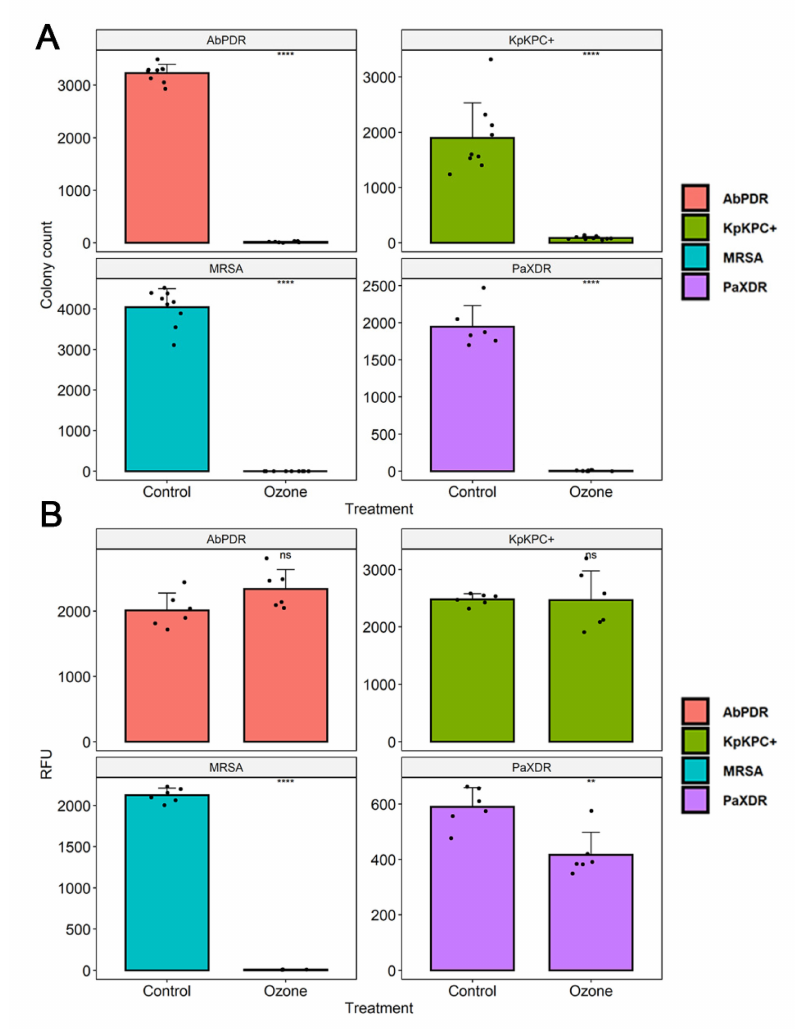
Figure 4. ( A ) The number of colony-forming units (CFU) in different bacterial strains ( S. aureus (MRSA), P. aeruginosa (XDR), A. baumannii (PDR), and K. pneumoniae (KPC+)) were counted. The number of CFU in the control group (no treatment) and bacterial suspensions (10 5 CFU/mL) after exposure to ozone for 40 min was quantified. The black dots represent the number of CFU count of the different strains. ( B ) Analysis of cell viability after ozone treatment in different bacterial strains ( S. aureus (MRSA), P. aeruginosa (XDR), A. baumannii (PDR), and K. pneumoniae (KPC+)). The measurement of fluorescence intensity (Relative fluorescence units, RFU) after the conversion of resazurin to resofurin by viable bacteria was performed in the control group (no treatment) and bacterial suspensions (10 5 CFU/mL) after exposure to ozone for 40 min. Results represent three randomly chosen colonies in the control group (no treatment) and after ozone treatment. The black dots show cell viability values through fluorescence emission after the addition of resazurin. ** Statistically significant ( p < 0.01); **** statistically significant ( p <